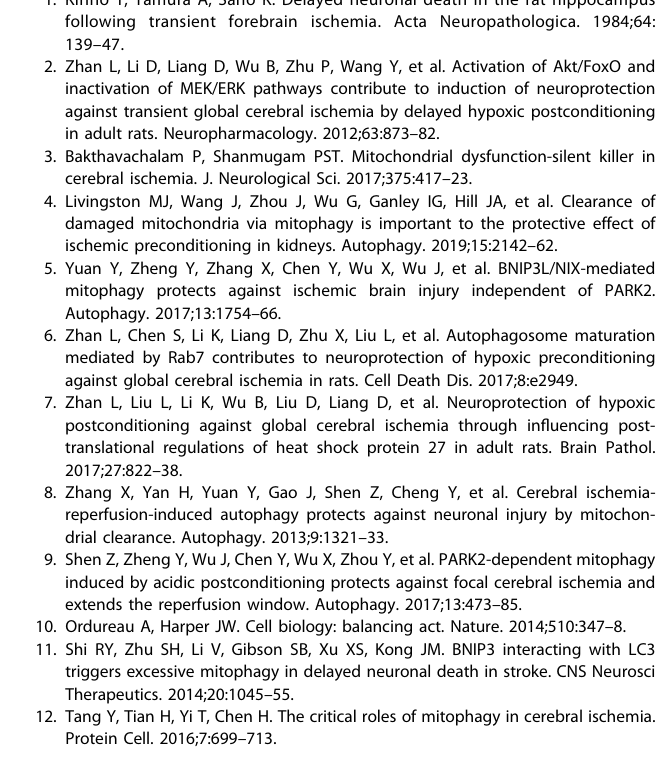
Fig. 8 Effects of AAVi-Parkin administration on neuronal cell damage, mitochondrial ubiquitination and mitochondrial clearance in CA1 after ischemia with HPC. A Phase contrast and fl uorescent images from coronal sections of CA1 following injection of AAVi-CON (a, b) or AAVi-Parkin (c, d) in Sham animals. White arrowhead shows the needle trace. Scale bar: 75 μ m. B , C Representative immunoblots of PINK1 and Parkin expressions in CA1. Data are expressed as percentage of value of Sham animals. Each bar represents the mean ± SD. * p < 0.05 vs. Sham animals and # p < 0.05 vs. Sham group with AAVi-CON injection ( n ≥ 4 in each group). D Representative microphotographs of cresyl violet staining and NeuN immunostaining in CA1 from rats administered bilaterally with either AAVi-CON or AAVi-Parkin at 7 d after reperfusion with hypoxia. Boxes indicate that the magni fi ed regions displayed in the right panel. Scale bar: a, c, e, g, i, k, m, o: 250 μ m; b, d, f, h, j, l, n, p: 25 μ m. E , F Quantitative analyses of surviving and NeuN-positive cells in CA1. Each bar represents the mean ± SD. * p < 0.05 vs. Sham animals and # p < 0.05 vs. the same group with AAVi-CON administration ( n = 6 in each group). G Western blot analyses of TOMM20, TIMM23, HSP60 and mtTFA in CA1. The histogram presents the quantitative analyses of TOMM20, TIMM23, HSP60, and mtTFA levels. Western blot analyses of PINK1, Parkin, and LC3 in the cytoplasmic fraction ( H ) and mitochondrial fraction ( I ) of CA1. The histogram presents the quantitative analyses of PINK1, Parkin, and the ratio of LC3-II/I. J Western blot analysis of ubiquitin in the mitochondrial fraction of CA1. The histogram presents the quantitative analysis of ubiquitin levels. Data are expressed as percentage of value of Sham animals. Each bar represents the mean ± SD. * p < 0.05 vs. Sham group and # p < 0.05 vs. the same group with AAVi-CON injection ( n ≥ 4 in each